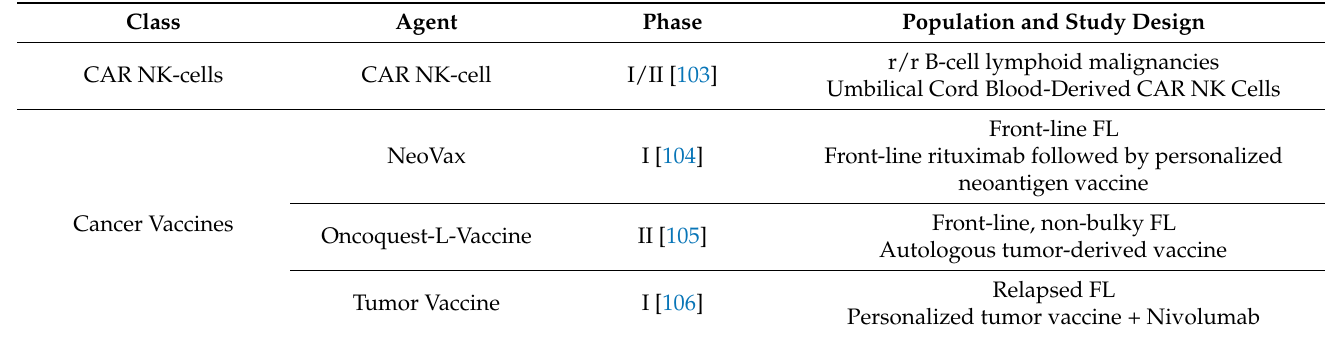
Table 2. Ongoing clinical trials of novel immune